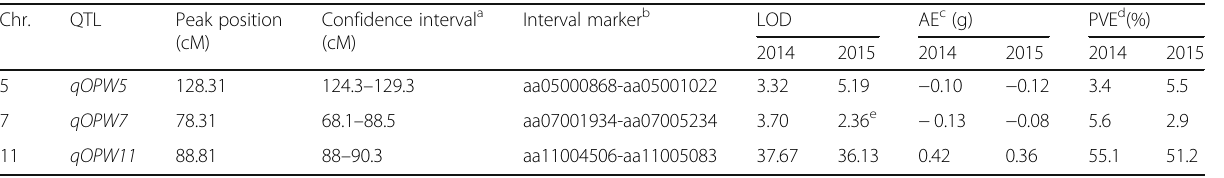
Table 1 The QTLs for one panicle weight Chr.